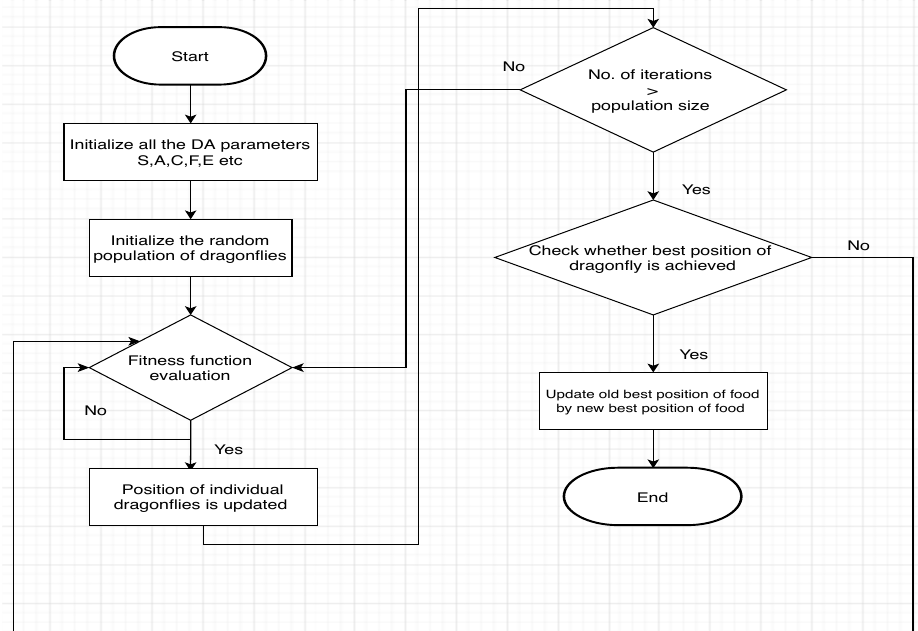
Figure 4. The Flowchart of Step by step process of the